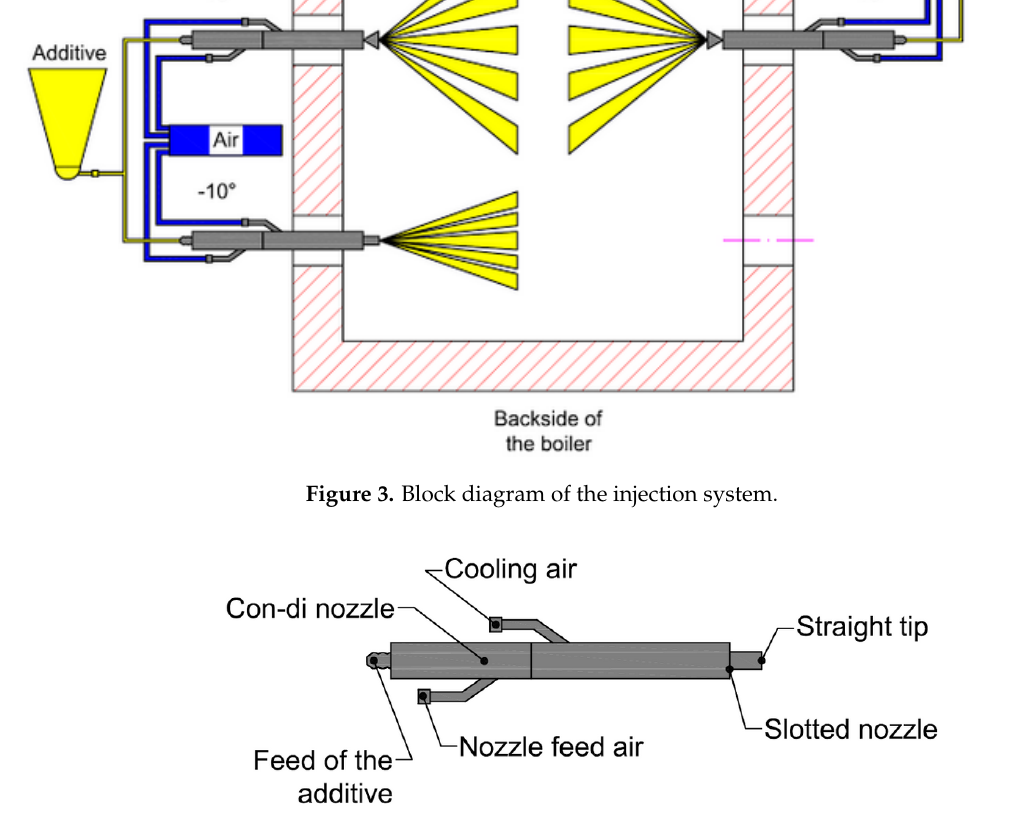
Figure 4. Straight nozzle for dry sorbent distribution.